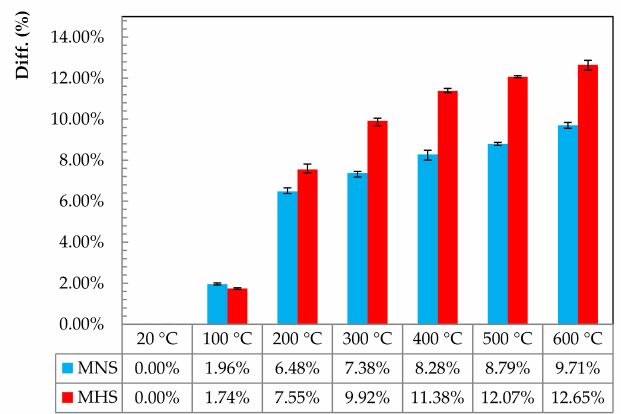
Figure 6. Relative weight loss (Diff.%) for MNS and